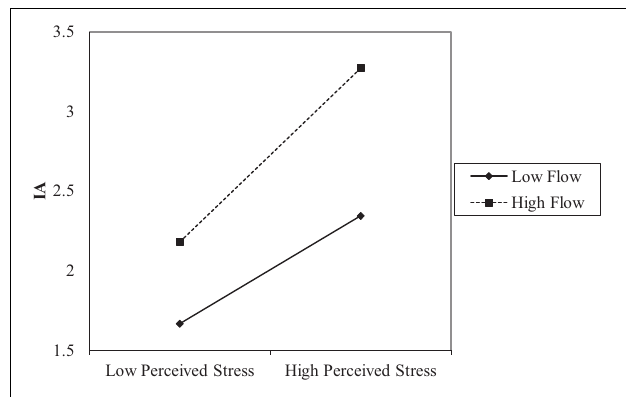
FIGURE 1 | A simple slope graph of perceived stress and Internet